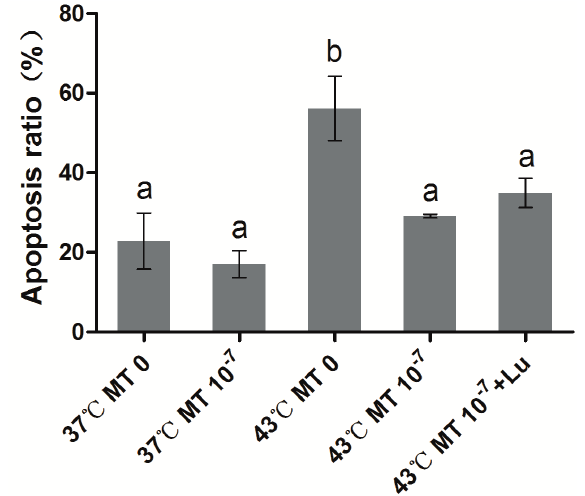
Figure 3. Effects of melatonin on granulosa cell apoptosis. MT: melatonin; Lu: luzindole. Each bar represents the mean ± SEM for experiments performed in triplicate. Different letters indicate significant differences, p <